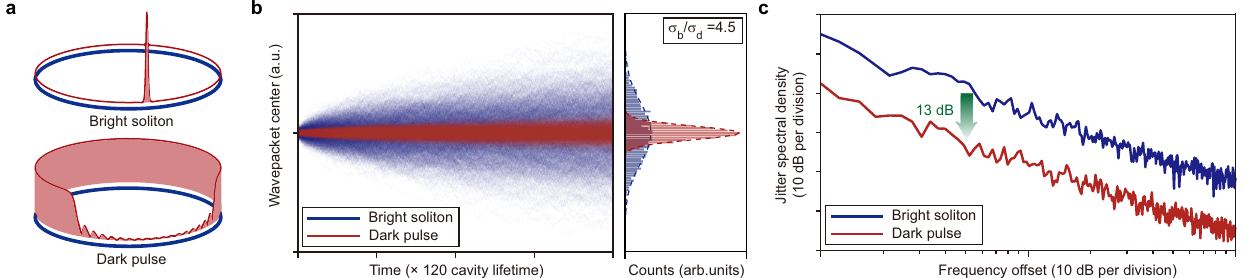
Fig. 5 | Performance comparison between bright solitons and dark pulses. a Intensity pro fi les of a bright soliton and a dark pulse. Parameters used in the simulations are: f =5.86, ζ =14, ∣ d 2 ∣ =0.0032. b Left panel: 2000 simulated traces showingtheevolutionofthewavepacketcenterunderquantum fl uctuations.Right panel: histograms showing the distribution of the wavepacket center at the end of